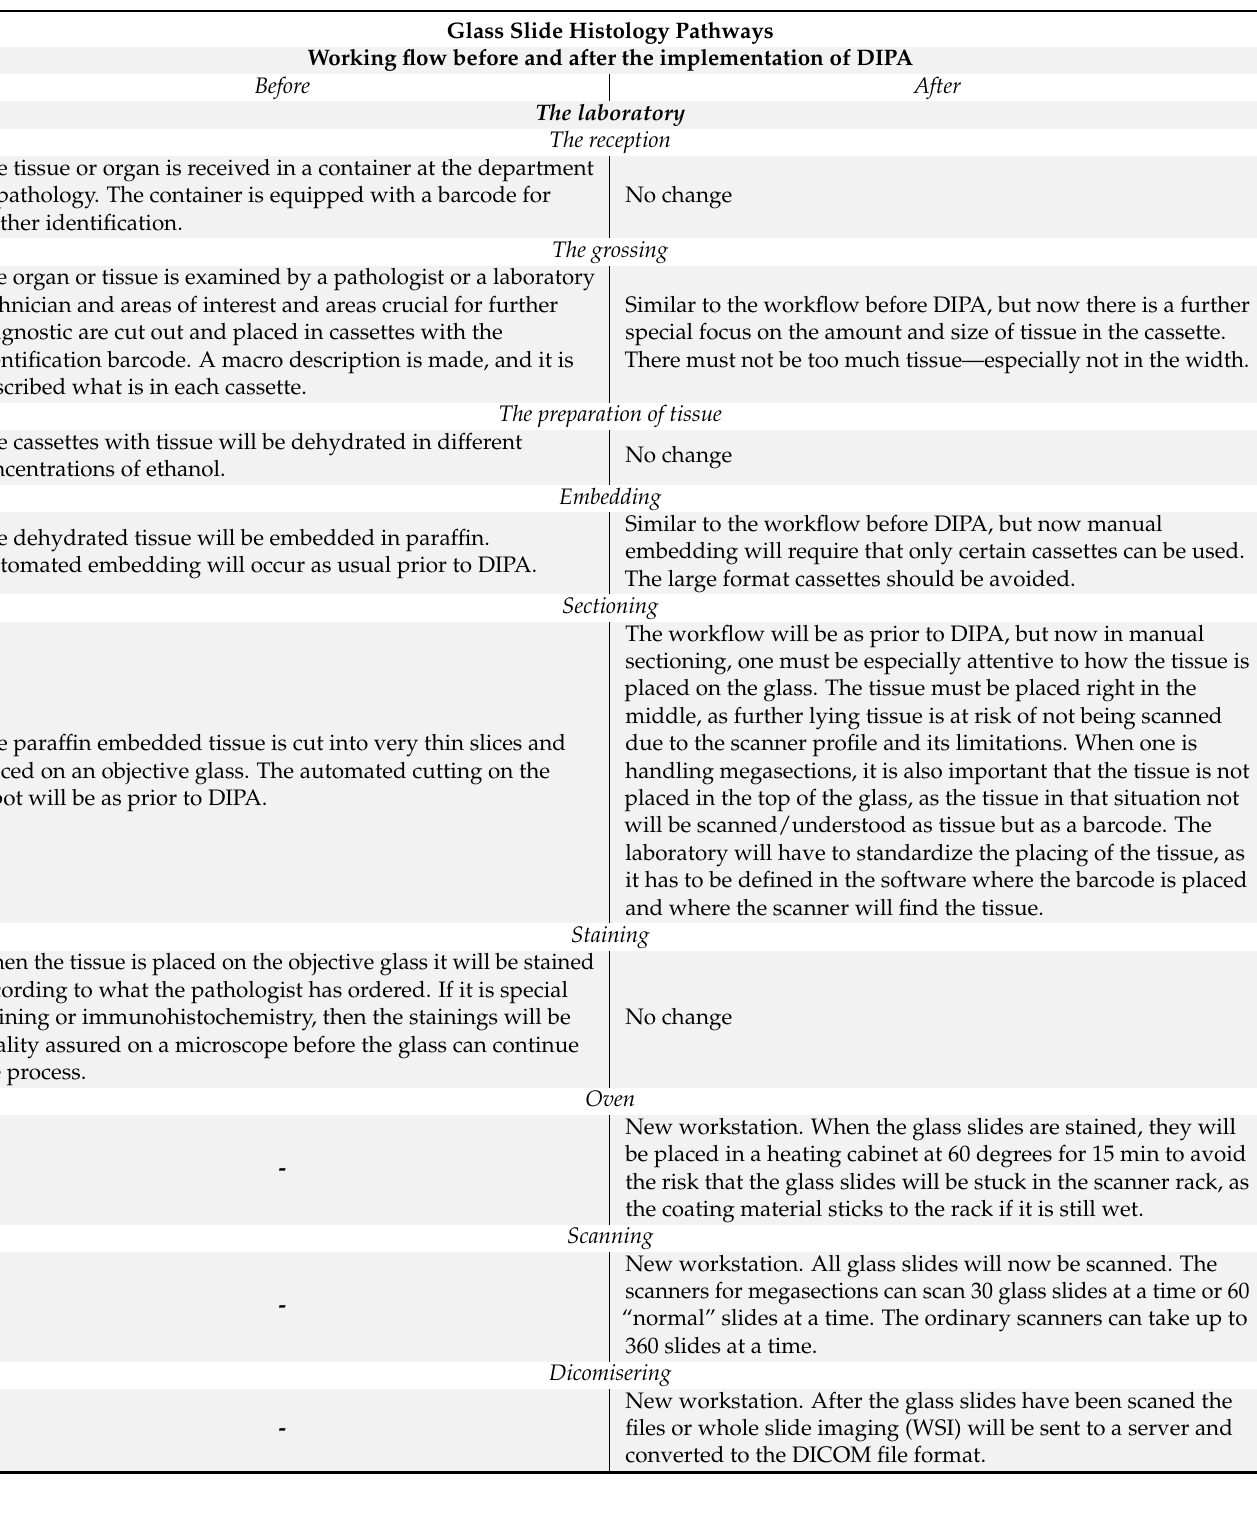
Table 2. The working processes from tissue to diagnosis in a department of pathology before and after the implementation of